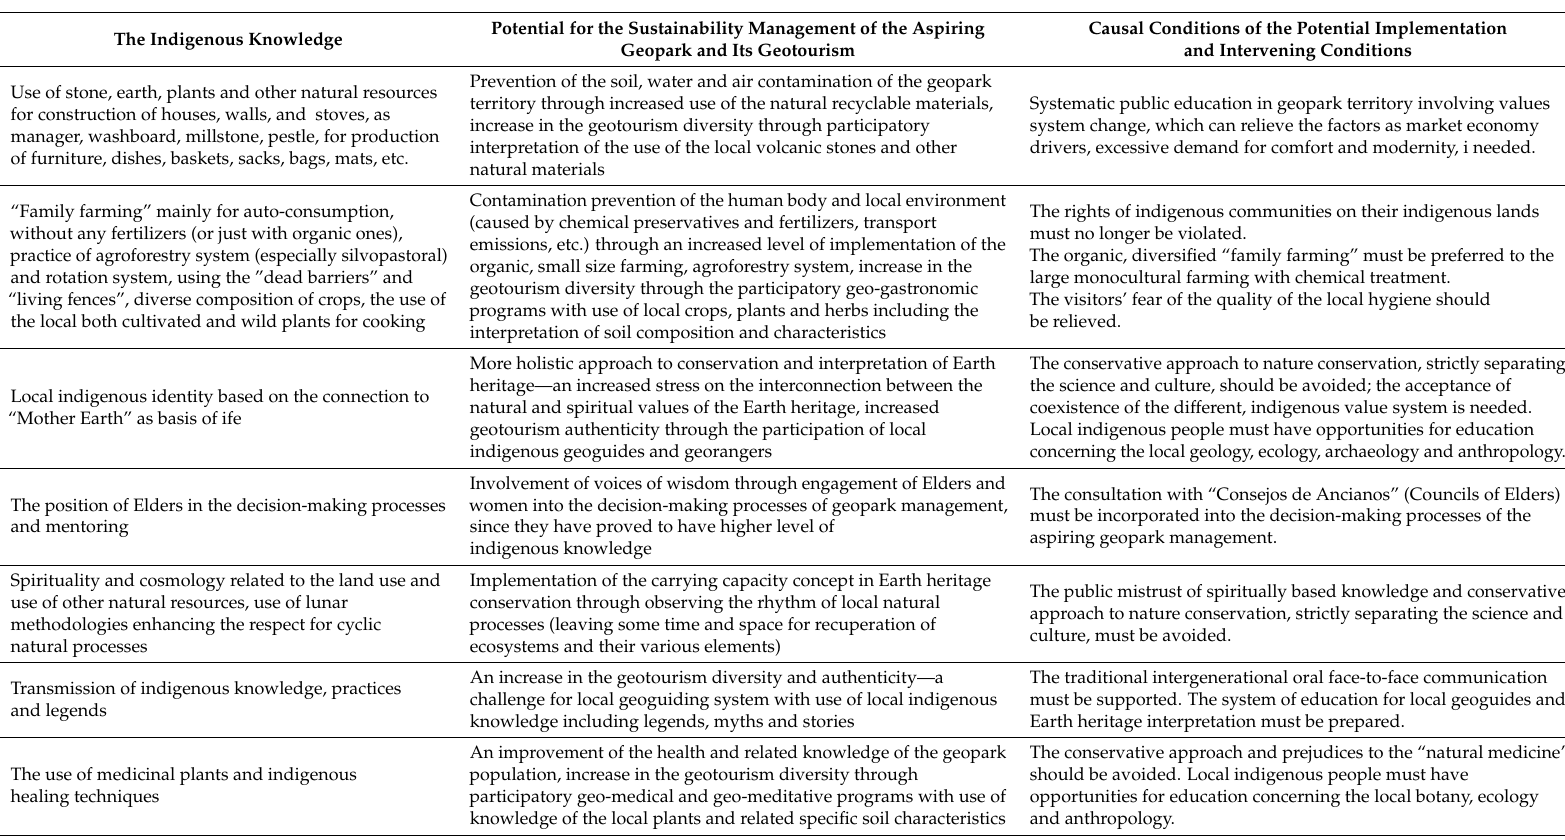
Table 3. The potential of the indigenous knowledge of El Apante community to contribute to the sustainability management of aspiring Rio Coco Geopark, especially to its geotourism and related